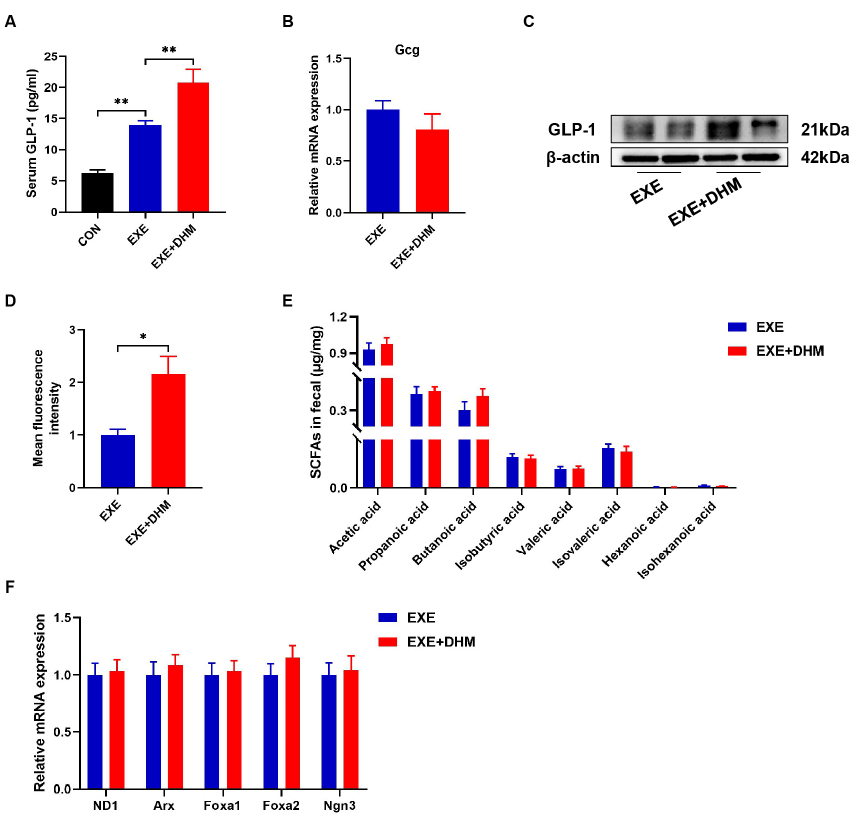
Figure 7. Dihydromyricetin enhances GLP ‐ 1 levels when combined with exercise. ( A ) GLP ‐ 1 levels were measured using an ELISA kit in serum. ( B ) qPCR analysis of the expression of the Gcg gene in the colon. ( C ) Representative western blot of GLP ‐ 1 from colon samples. ( D ) Analysis of GLP ‐ 1 pos ‐ itive expression in immunofluorescence staining of GLP ‐ 1 for colon samples using Image J. ( E ) SCFAs content in fecal samples, n = 8. ( F ) qPCR analysis of the expression of the regulators of L cell proliferation in the colon. Data are expressed as the mean ± SEM. One ‐ way ANOVA: ( A ). Unpaired t ‐ test: ( B , D , E ). * p < 0.05, and ** p < 0.01.